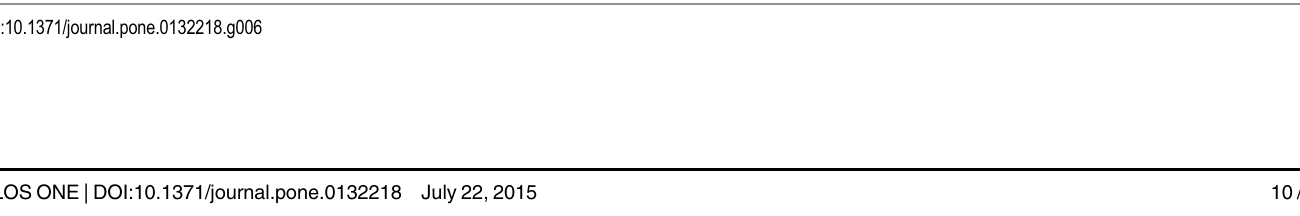
PLOS ONE | DOI:10.1371/journal.pone.0132218 July 22,